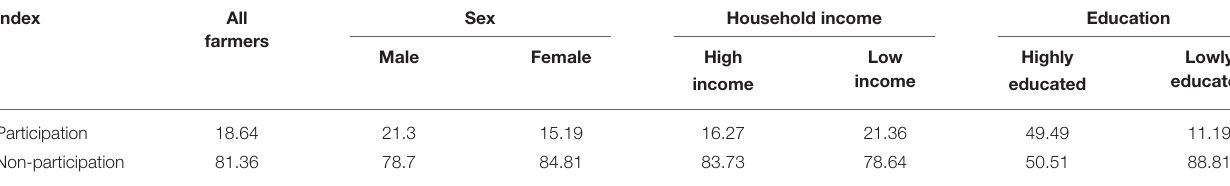
TABLE 1 | The results of the participating respondents in e-commerce poverty alleviation.